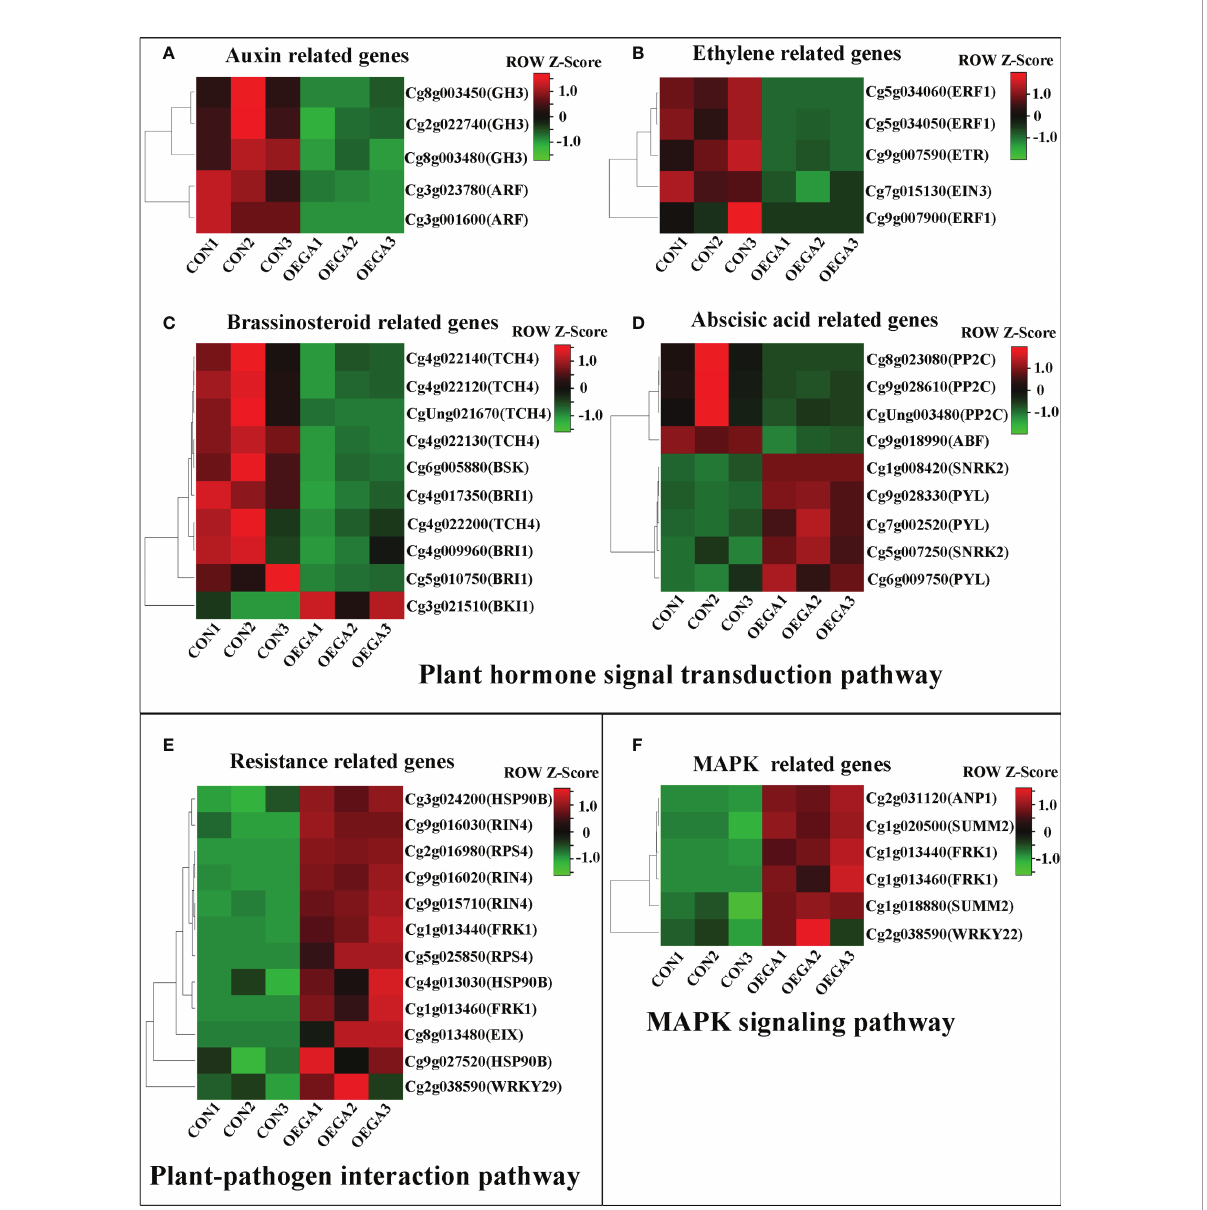
FIGURE 3 Heatmap of the DEGs in the OEGA and CON plants. (A – D) Heatmap of the plant hormone signal transduction pathway genes. (E) Heatmap of the plant – pathogen interaction pathway genes. (F) Heatmap of the MAPK pathway genes. The bar represents the scale of the expression levels of each gene (reads per kilobase per million mapped reads; FPKM) in the different samples, as indicated by the red and green rectangles. The metabolite production levels in the heatmaps were normalized by Z-scores. Genes in red indicate upregulation, whereas those in green indicate